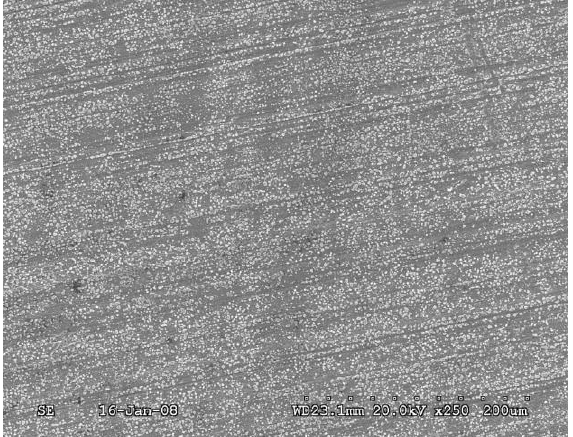
Fig. 1. Image of inside working surface of the nozzle tip body. Visible lines of machining shaping the surface of mating with the nozzle needle. Oxide bands arranged in accordance with the machining lines draw atten- tion